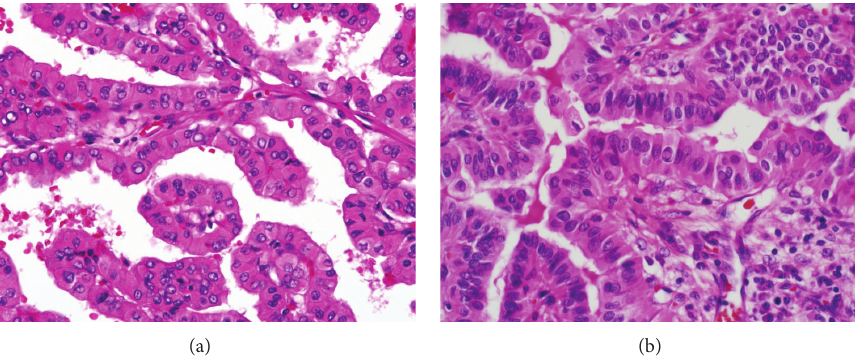
Figure 3: Differential diagnosis of the Warthin-like variant of papillary carcinoma includes oncocytic and tall cell variants. (a) The oncocytic variant has eosinophilic granular cytoplasm. (b) The tall cell variant contains tall cells with a height at least twice their width and eosinophilic cytoplasm. Dense stromal lymphoplasmacytic infiltration is absent in both oncocytic and tall cell